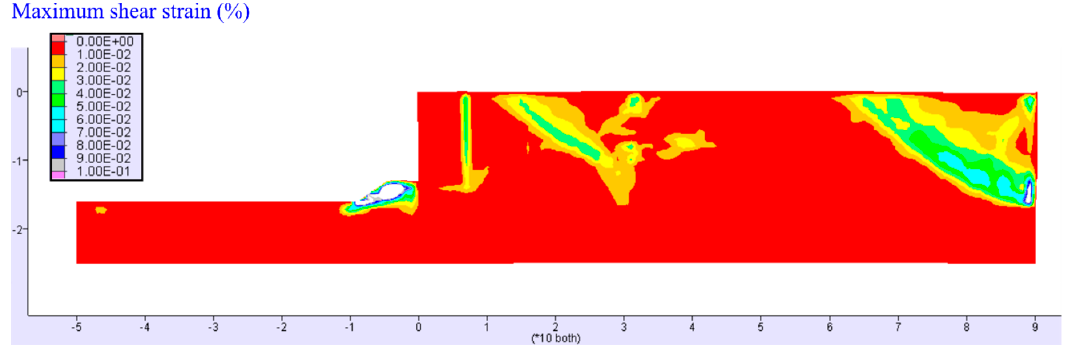
Figure 22. Maximum shear strain at the end of shaking contours (scale up to 10%, dimension unit in meters).